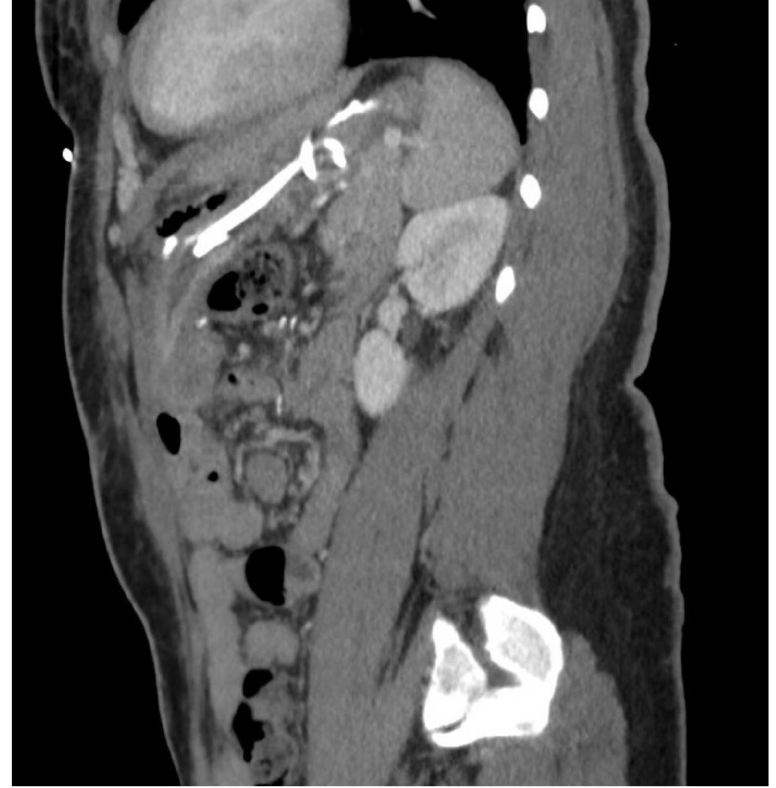
Figure 21. Internal pigtail stents seen on lateral view.